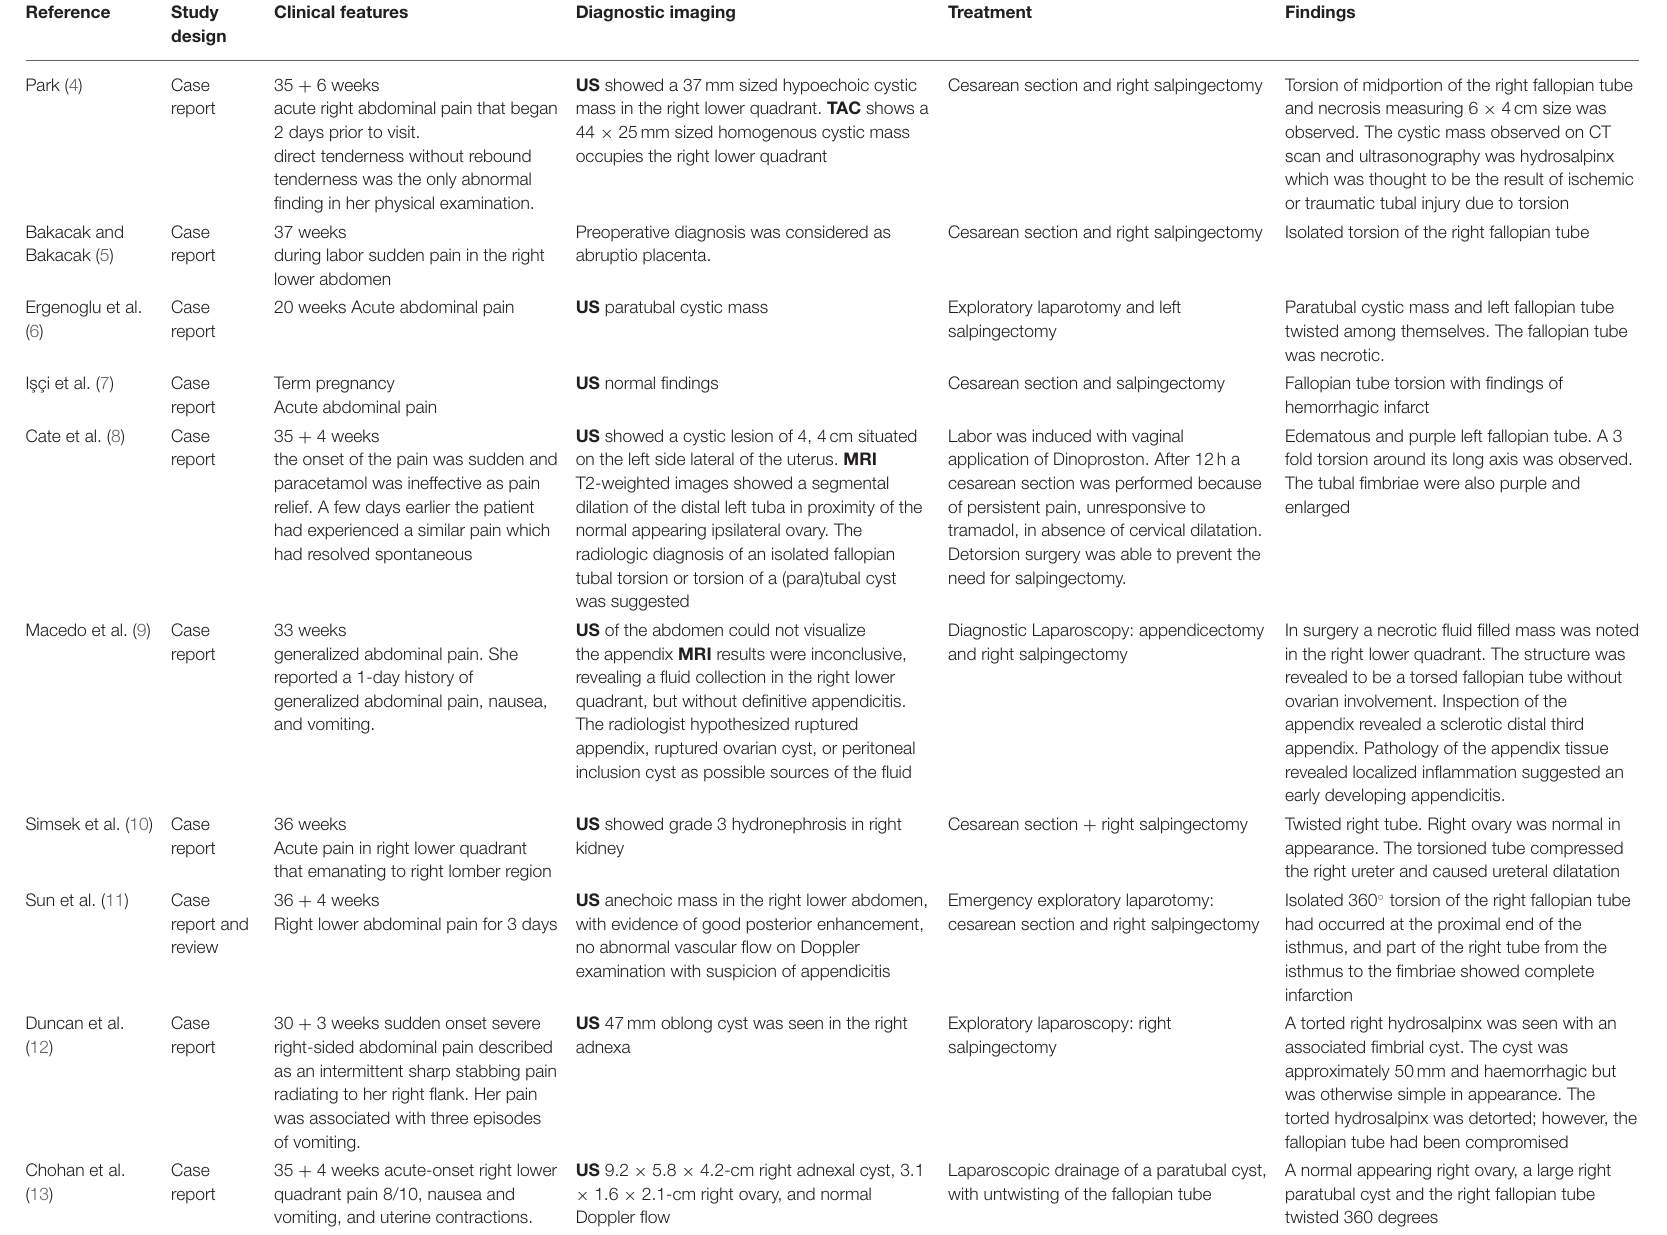
TABLE 1 | Systematic research of the